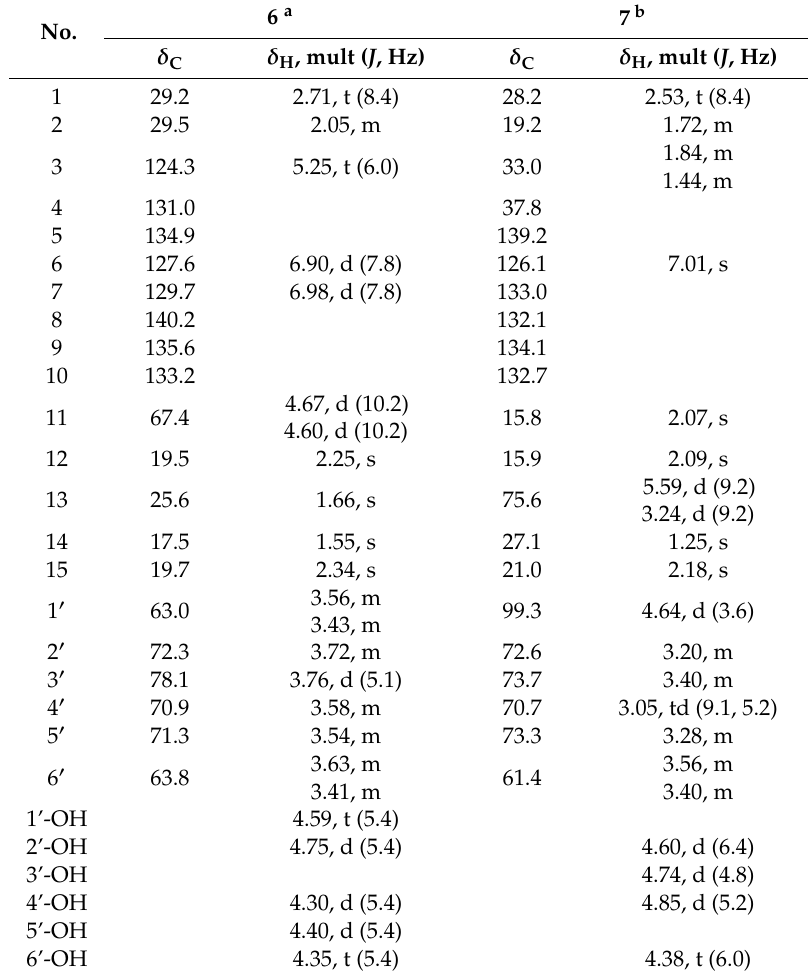
Table 2. NMR spectroscopic data of 6 and 7